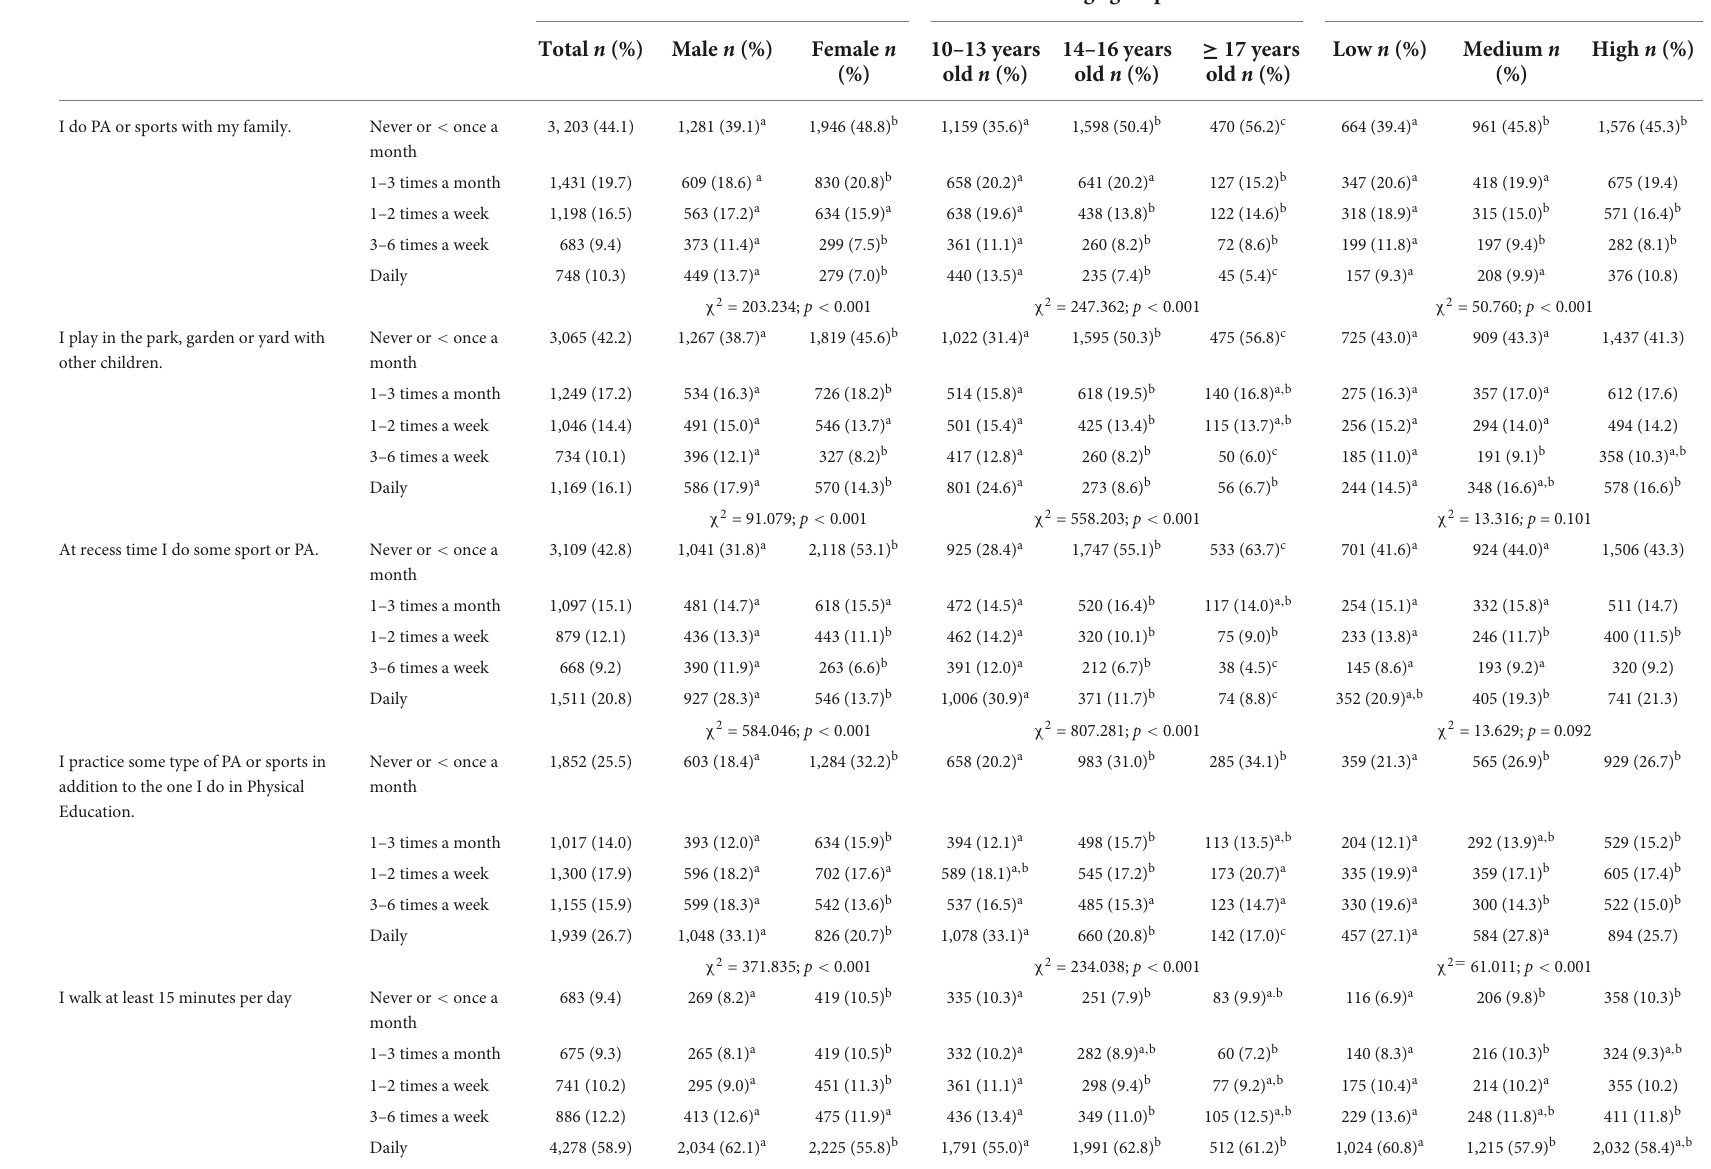
TABLE 2 Physical activity habits based on the sociodemographic factors